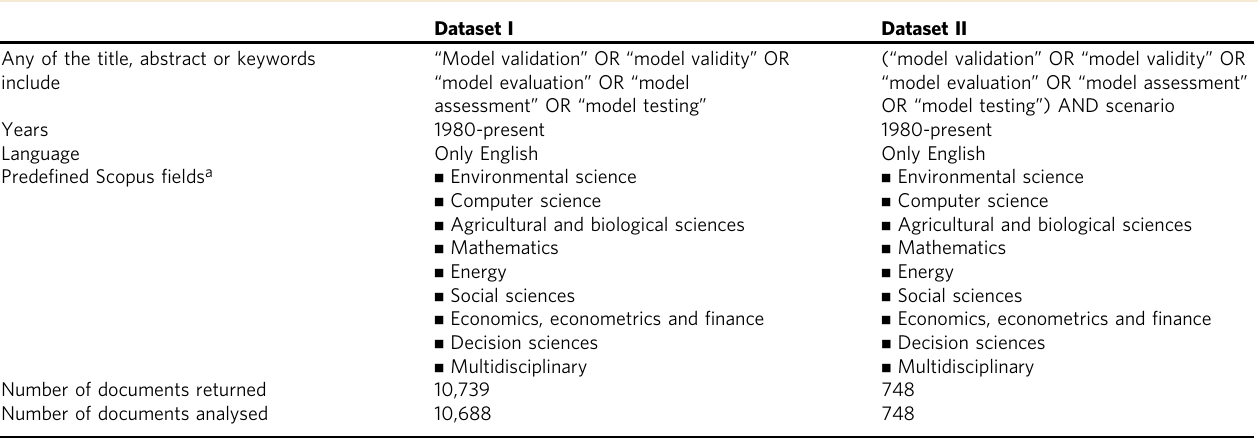
Table 1 Speci fi cations of the datasets analyzed by text